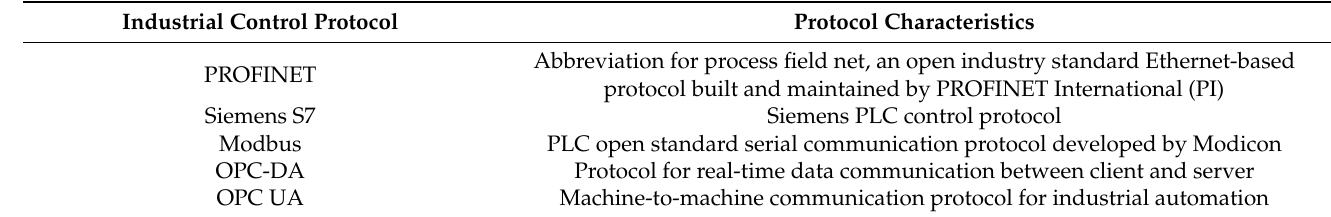
Table 2. Types and characteristics of major control protocols.